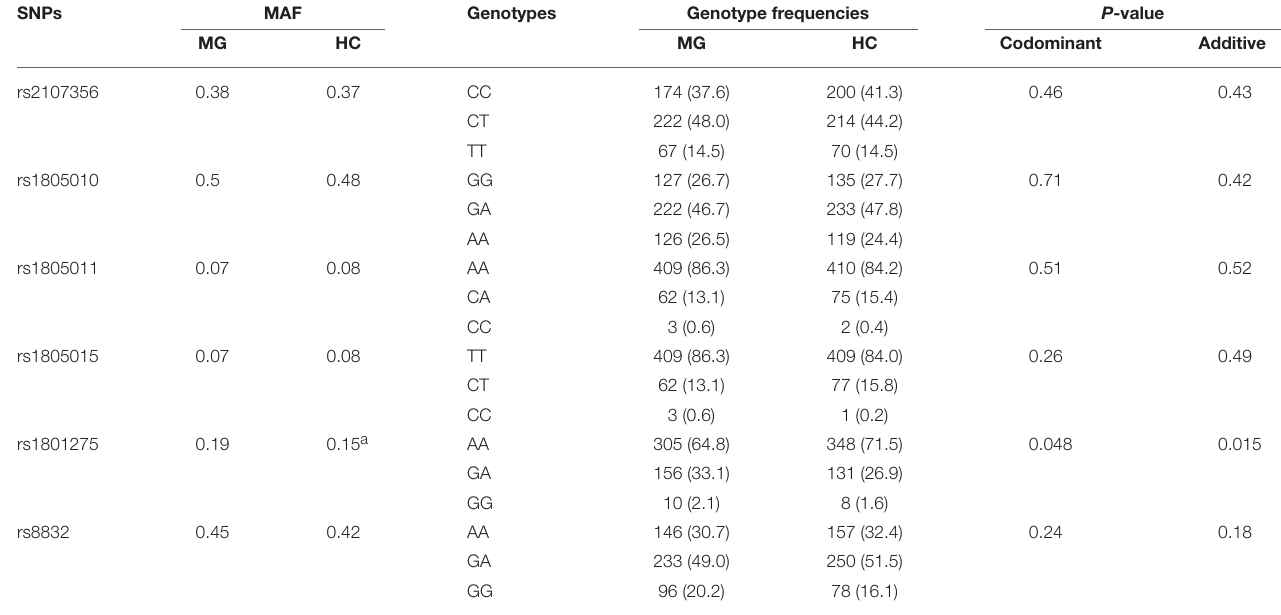
TABLE 2 | Distribution of SNPs among all 480MG patients without any subgroup distinction and 487